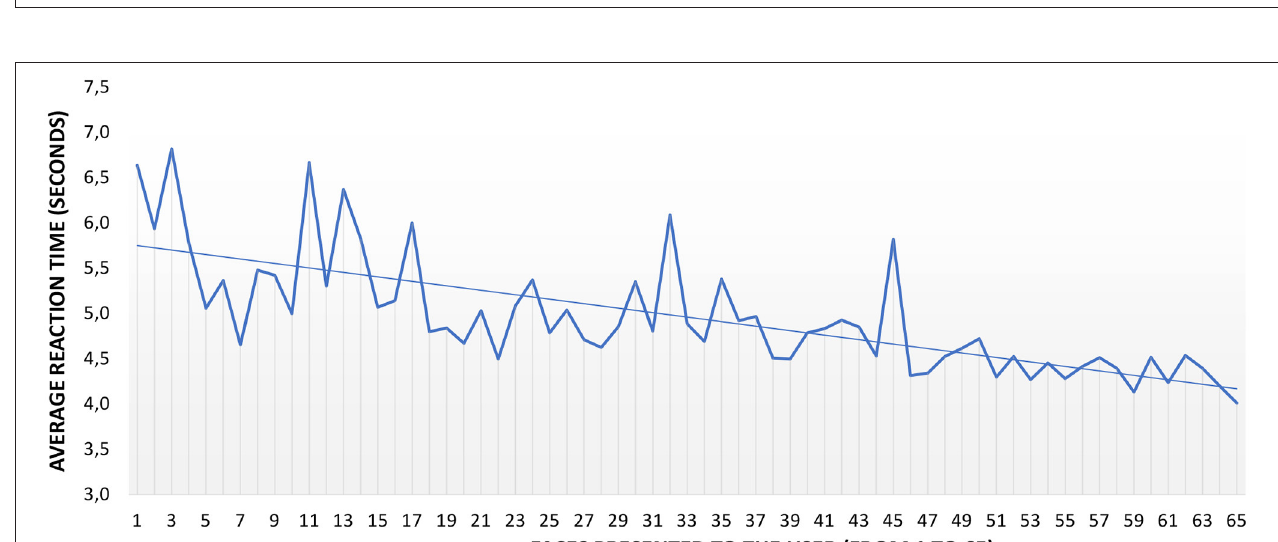
FIGURE 7 | Average reaction time for each face presented to the users. The trend line shows a negative slope of